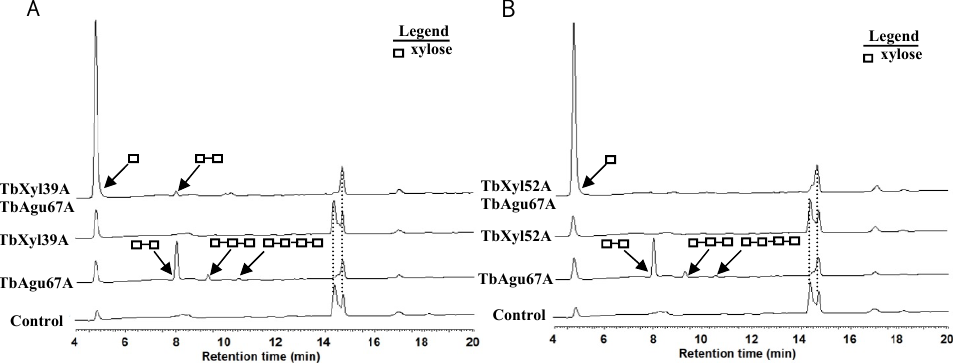
Figure 5. Synergistic effects between TbAgu67A and each of the two β -xylosidases (TbXyl39A and TbXyl52A) in hydrolysis of aldouronic acids. ( A ) and ( B ) HPAEC-PAD analysis of aldouronic acids incubated with TbAgu67A alone or with TbXyl39A ( A ) or TbXyl52A ( B ). 400 nM of TbXyl39A (or 100 nM of TbXyl52A) and 200 nM of TbAgu67A were incubated individually or together with 1 mg/mL of aldouronic acids in a total volume of 30 µL, at 60 °C in the citrate buffer (pH 5.5) for 1 h. The end products of hydrolysis were diluted (400-fold) and centrifuged before analysis by HPAEC- PAD. Xylose (X1) and xylo-oligosaccharides (X2 – X6) were used as standards. 2.7. The Two Oxidoreductases Improve Hydrolysis of Xylans by the T. bryantii Hemicellulases